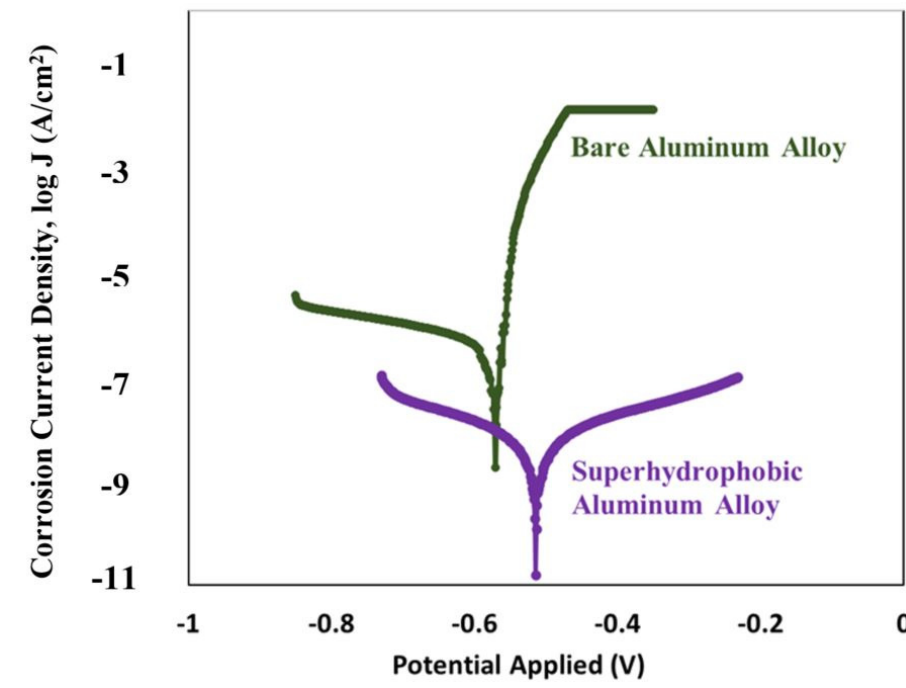
Figure 12. Potentiodynamic polarization curves for bare aluminum alloy surface and the superhydrophobic nanocomposite coating .